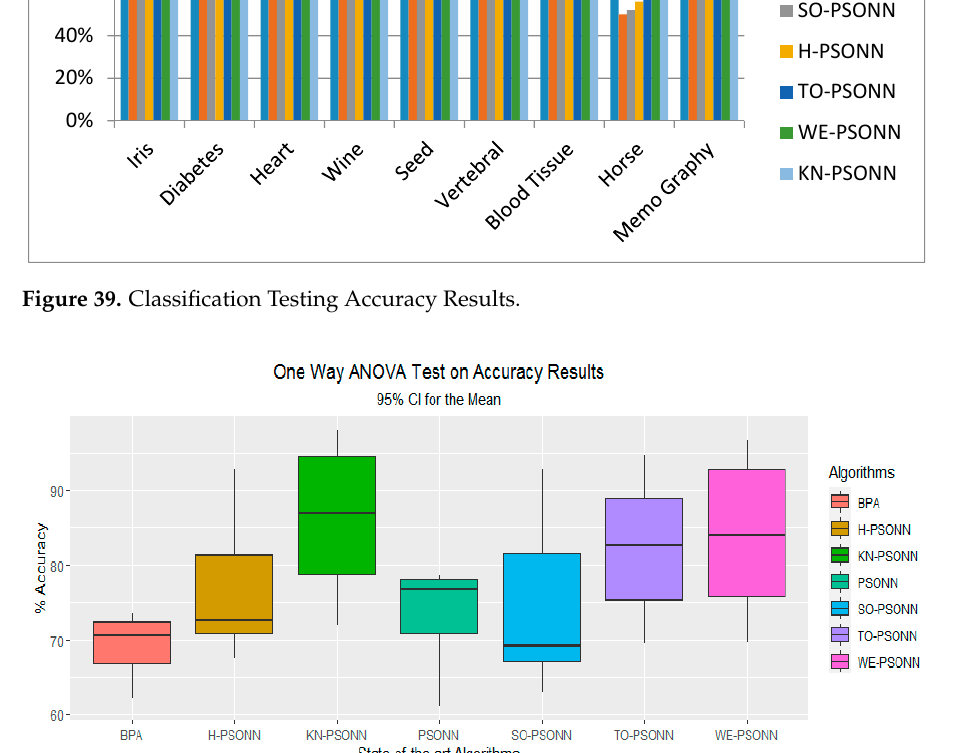
Figure 40. Box plot visualization of the results achieved by the training of FFNN for all PSO-based initialization approaches and BPA for given data set of classification problem.